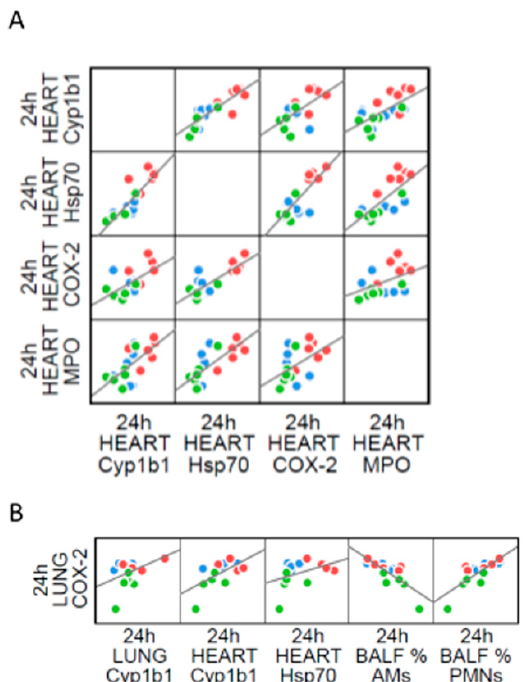
Figure 8. Correlation analysis between inflammation and oxidative stress in sub-acute treatment. Dispersion plot showing the co-distribution of markers intra-heart ( A ) and of lung COX2 with heart and BALf parameters ( B ). Linear regression correlations are displayed as black lines.